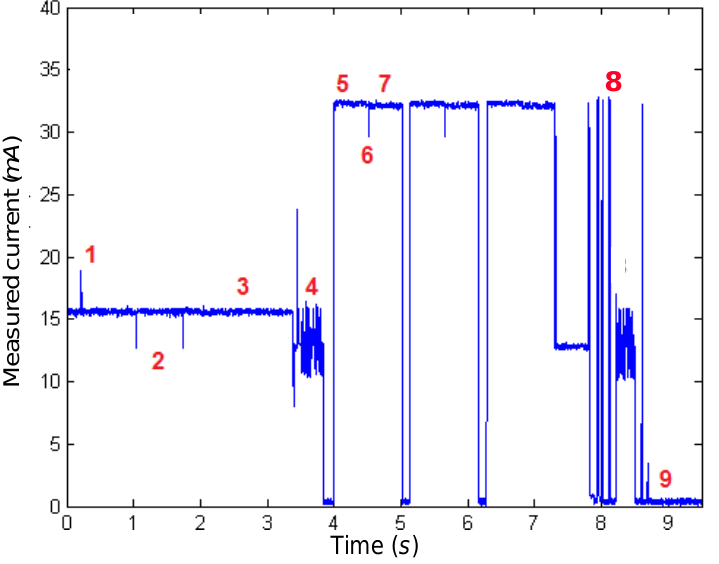
Figure 3. Measured supply current during the association to the